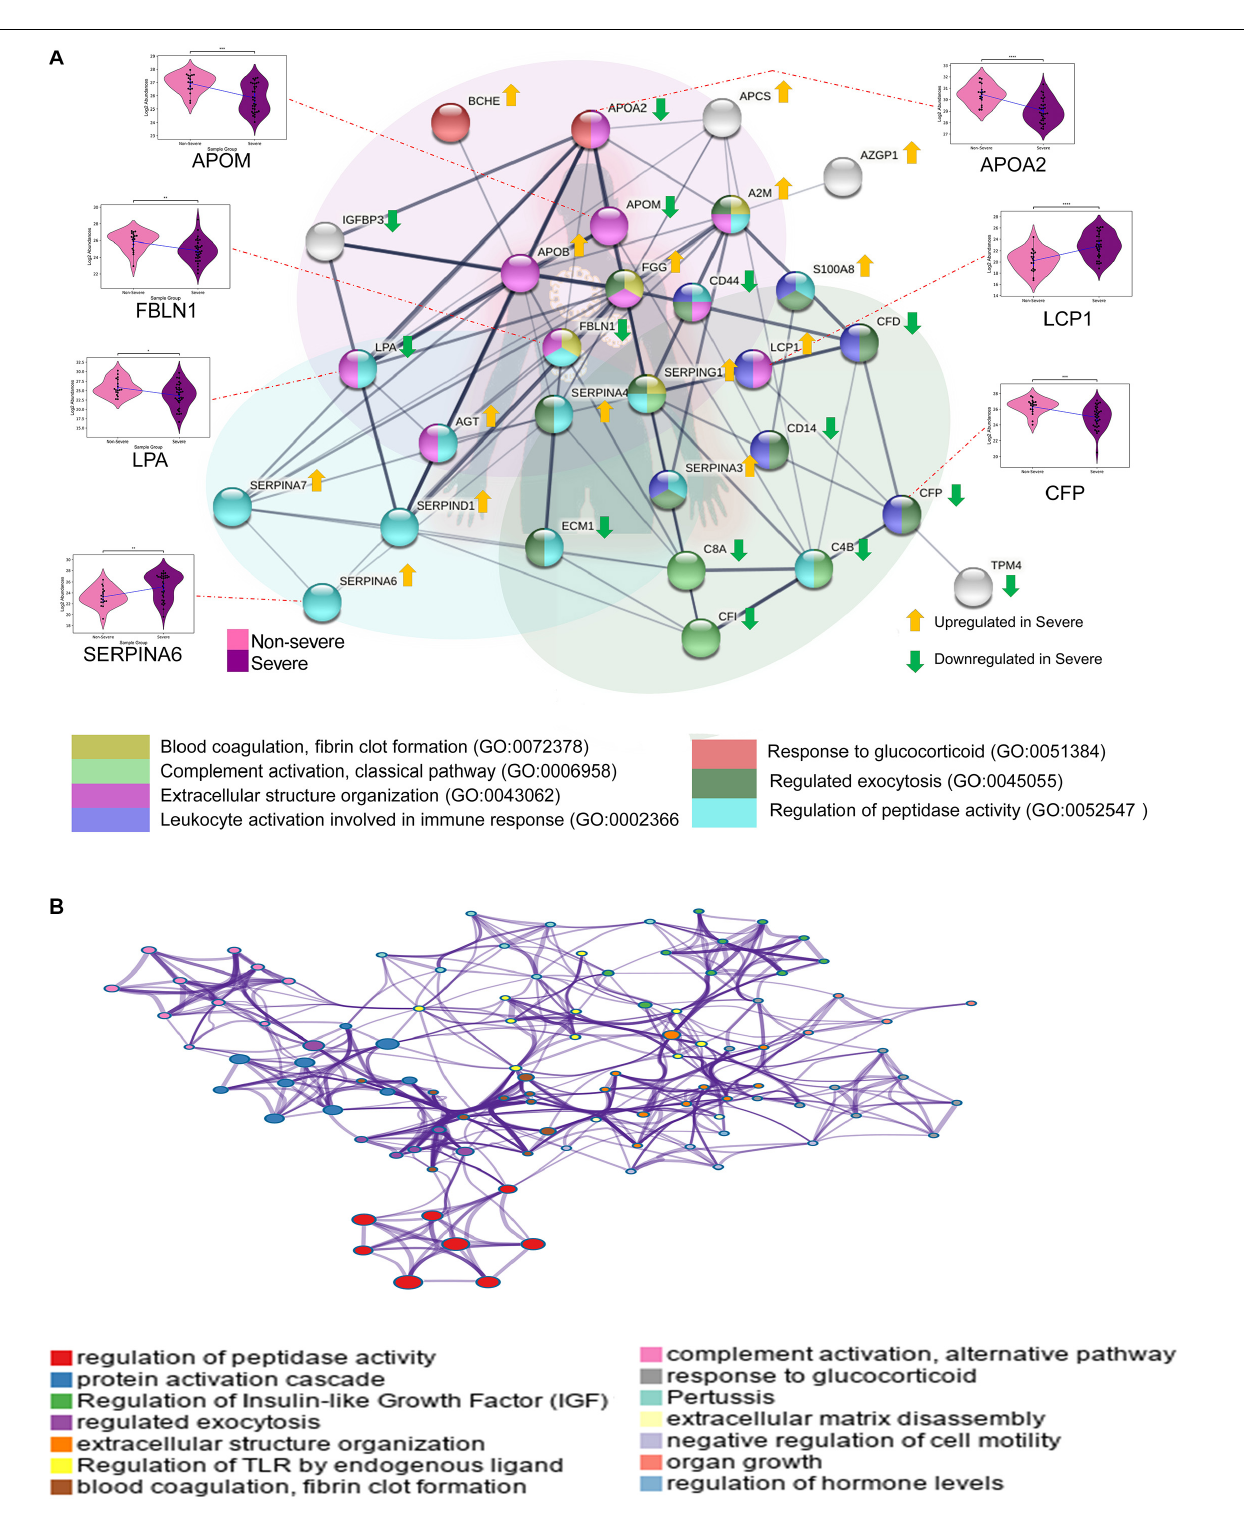
FIGURE 4 | Biological pathways and network analysis of differentially expressed proteins in severe vs. non-severe comparison. (A) Represents the Metascape enriched biological processes with their co-expressed proteins in the form a bipartite network where few proteins have been shown in the form violin plot (ns: 5.00e-02 < p ≤ 1.00e + 00; *1.00e-02 < p ≤ 5.00e-02; **1.00e-03 < p ≤ 1.00e-02; ***1.00e-04 < p ≤ 1.00e-03; **** p ≤ 1.00e-04). (B) The network of enriched terms, generated using String (version 11.0) shows colored clusters, where the nodes that share the same clusters are typically close to each other.